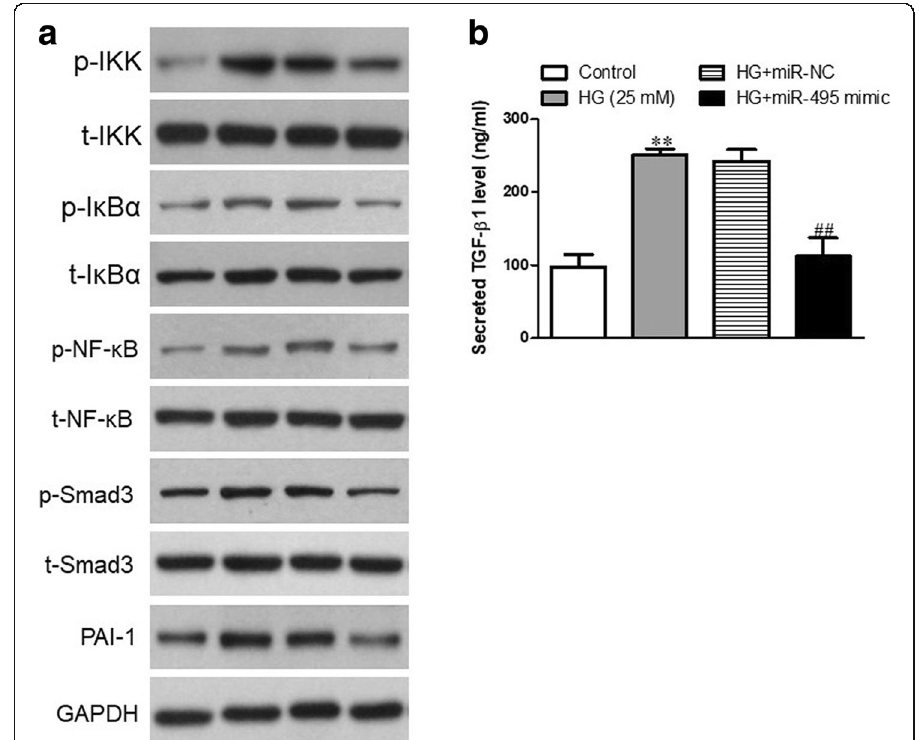
Fig. 6 The effects of miR-495 on high glucose-induced NF- κ B and TGF- β 1/Smad signaling pathways. CFs were transfected with miR-495 mimic for 48 h, and then treated with 5.5 or 25 mM glucose for 24 h. a The protein expressions of p-IKK, t-IKK, p-I κ B α , t-I κ B α , p-NF- κ B, t-NF- κ B, p-Smad3, t-Smad3 and PAI-1 were determined via western blot. b The secreted TGF- β 1 proteins in the supernatants of CFs were detected using ELISA assays. All data are presented as means ± SEM ( n = 4). ** p < 0.01 vs. control; ## p < 0.01 vs. vehicle + high glucose. The vehicle is transfection reagent